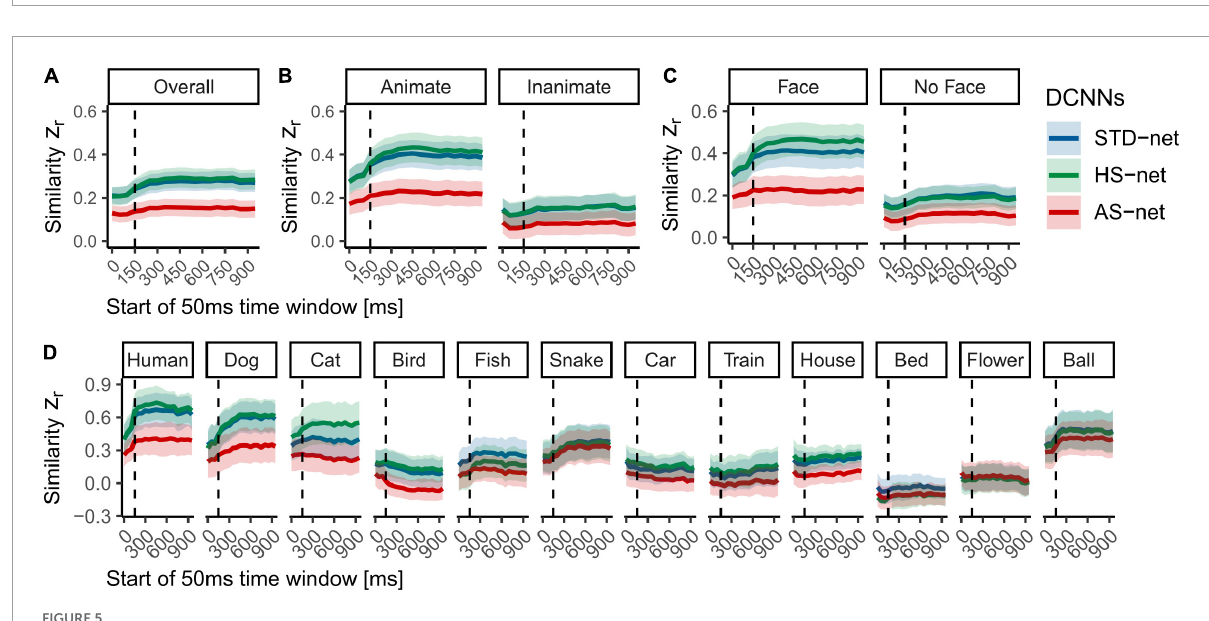
FIGURE5 Mean Fisher’s Z transformed Pearson correlations between DCNN GradCAMs and eye tracking heatmaps for all individual testing images across time. (A) Overall similarity of standardly fine-tuned STD-nets, purposefully manipulated HS-nets, and inversely manipulated AS-nets compared to eye tracking heatmaps across the first 1,000 ms within the image boundaries. (B) Similarity across time split by animacy. (C) Similarity across time split by face presence. (D) Similarity across time split by category. Shaded areas display bootstrap confidence intervals. The dotted line marks the transition from feedforward to recurrent processing at ∼ 150